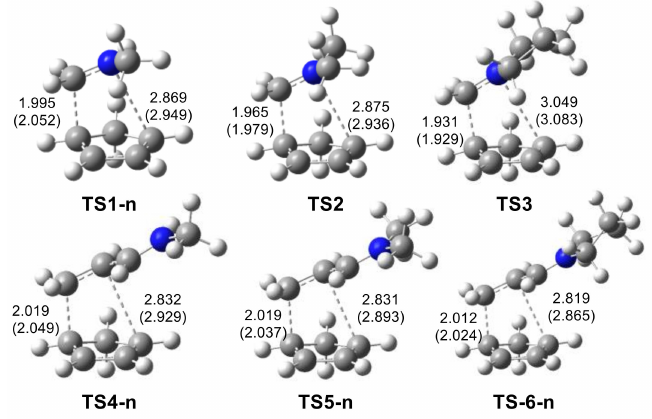
Figure 5. ω B97XD/6-311G(d,p) geometries of the endo TSs for DA reactions of iminium cations 6 , 15 – 19 with Cp 1 . The C–C and C–N distance are given in Angstroms. The gas phase distances are given in